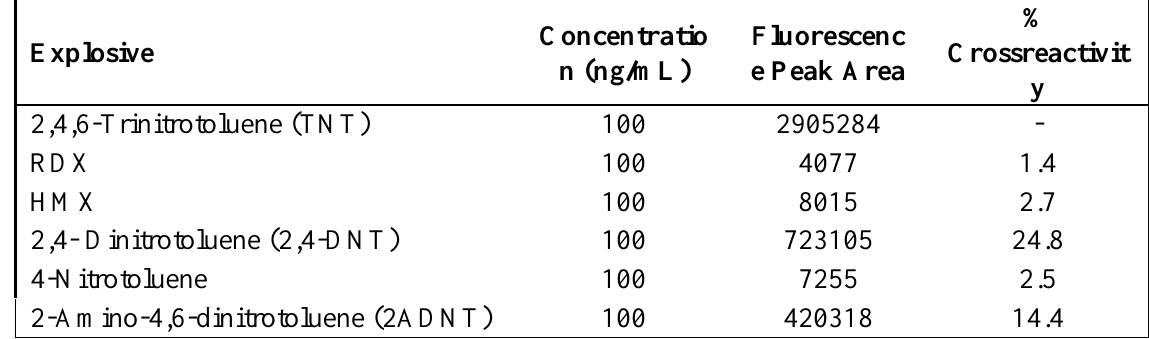
Table 1. Percent crossreactivity of explosives to TNT antibody. Explosive samples applied in TNT immunoassay at a concentration of 100 ng/mL. All samples were applied in duplicate. Fluorescence peak areas were averaged and percent (%) crossreactivity